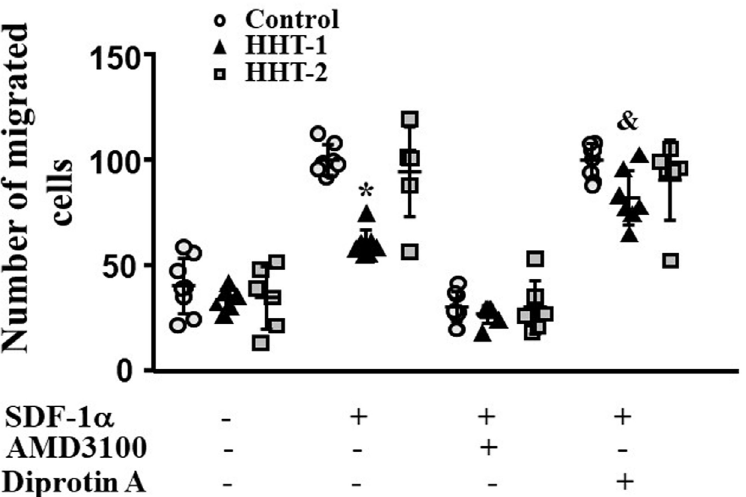
Figure 1. Reduction of HHT1 MNC migration toward SDF-1α. N = 8 for control MNCs; N = 7 for HHT1 MNCs; and N = 6 for